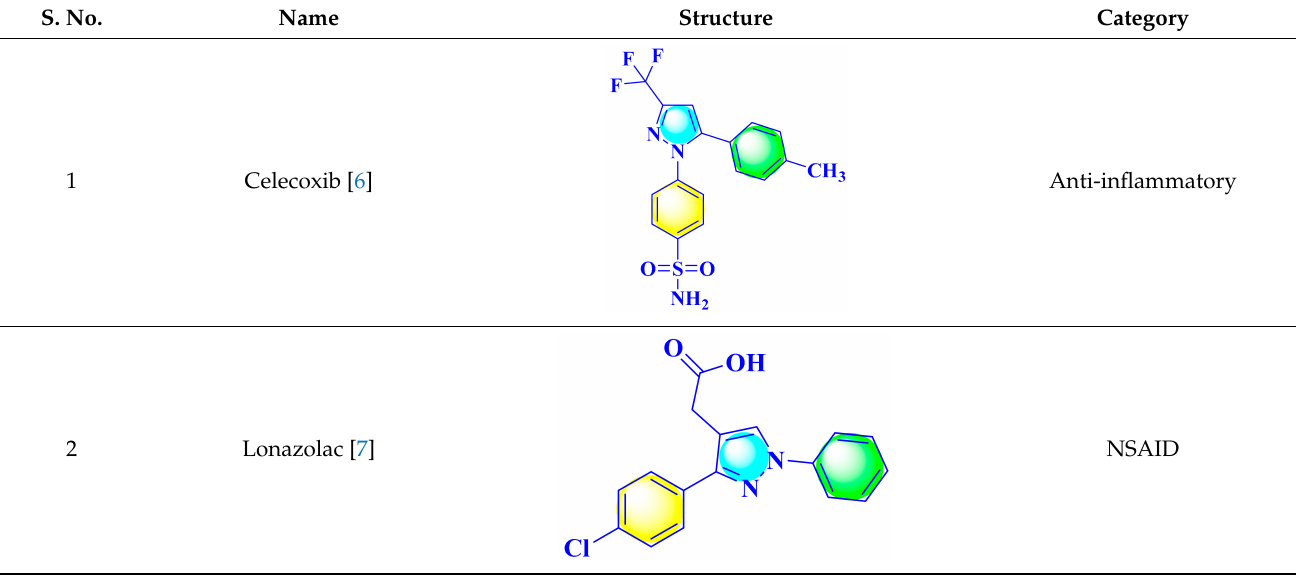
Table 1. Representative drugs containing the pyrazole